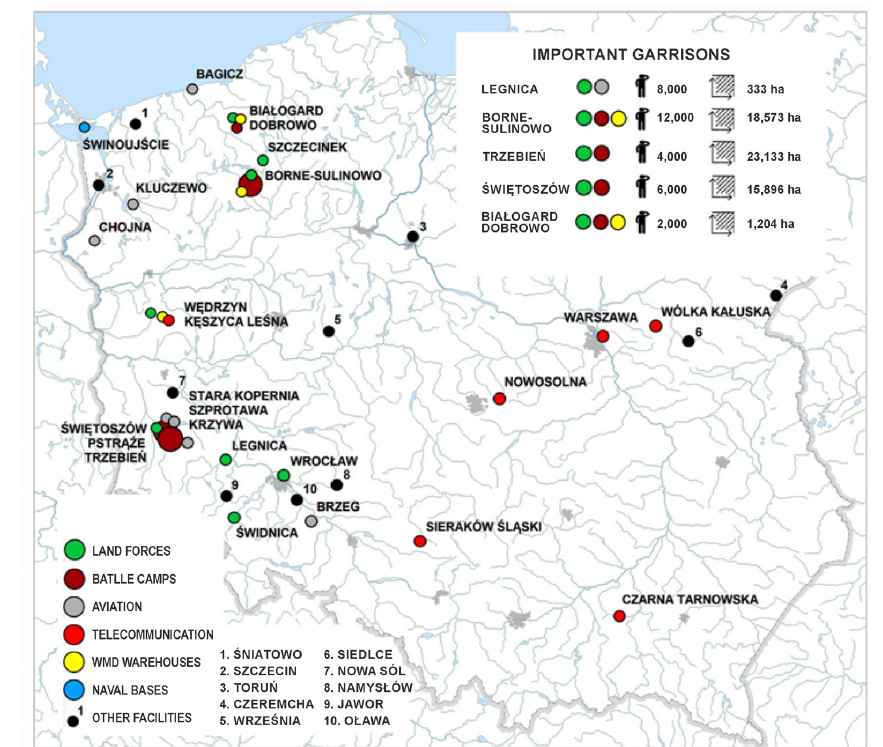
Fig. 1. The location of Soviet bases in